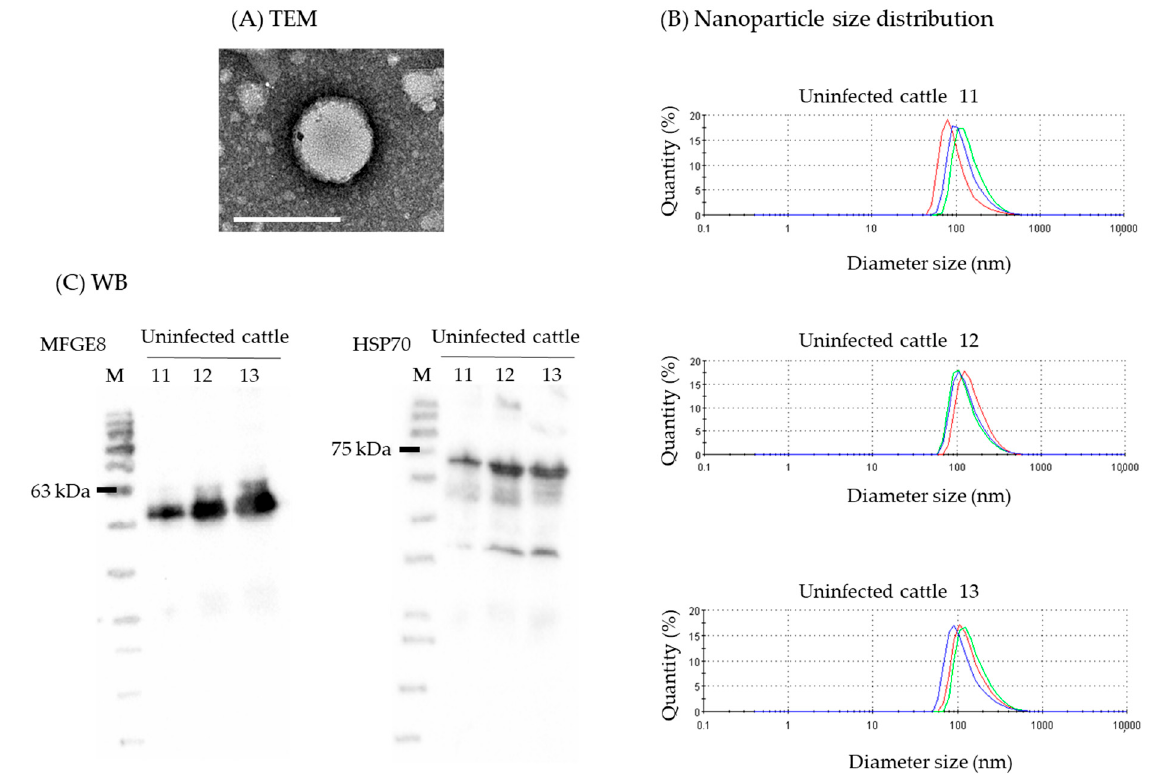
Figure 1. Characterization of isolated milk small extracellular vesicles (sEVs). ( A ) Transmission electron microscopy (TEM) analysis showing the bilayer spherical shape of milk sEVs (Scale bar shows 100 nm). ( B ) Nanoparticle size analysis to determine the size distribution of milk sEVs. Mean peak size of three measurements (red, blue, and green) was observed to be approximately 100 nm in diameter. ( C ) Western blot (WB) analysis using antibodies against sEV surface and internal marker proteins, MFGE8 and HSP70, respectively.